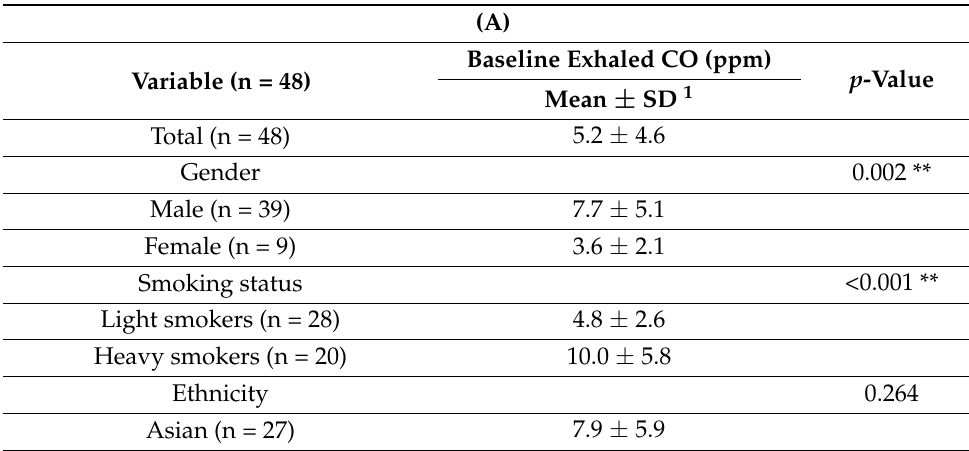
Table 2. ( A ). Comparison of baseline exhaled CO concentration between different groups in smokers. ( B ). Comparison of exhaled CO half-life between different groups in